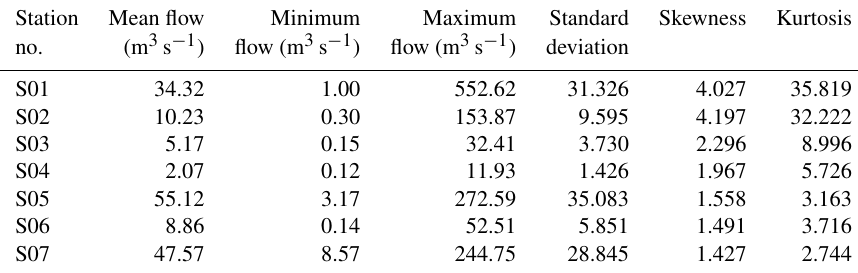
Table 3. The statistical analysis for time series of streamflow (1978–2017). Station Mean flow Minimum Maximum Standard Skewness Kurtosis